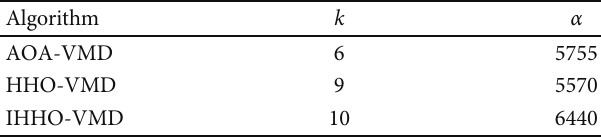
Table 2: The optimum parameters of each